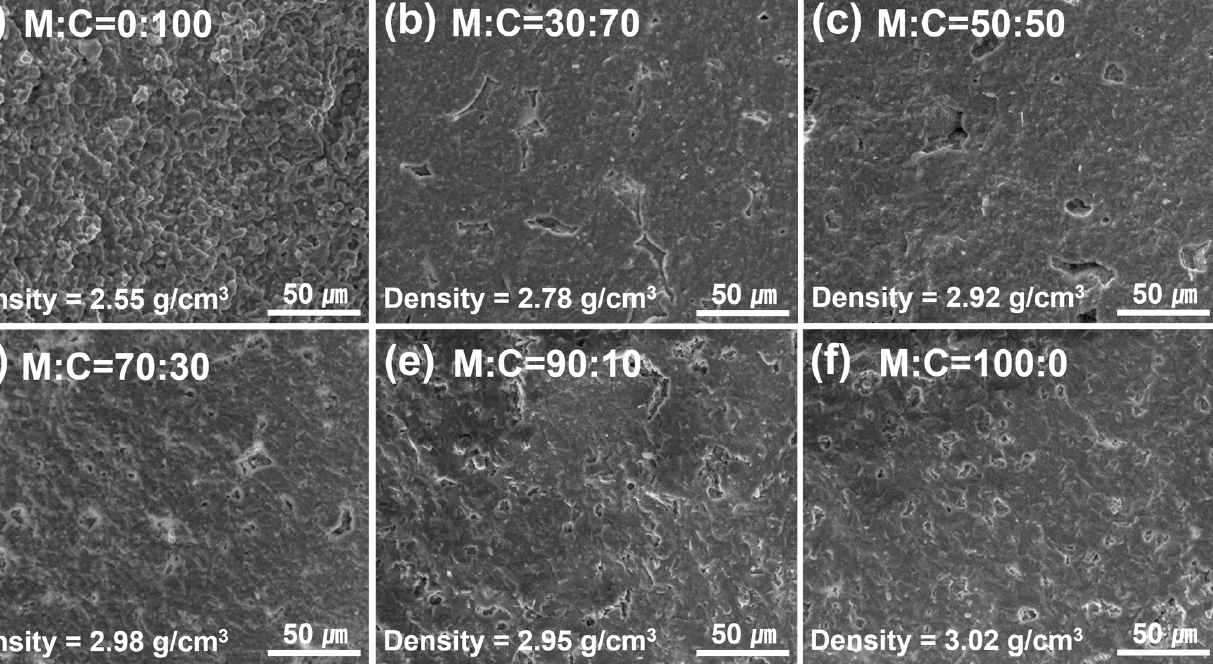
Figure 4. SEM images of the mullite–cordierite composite sintered at 1300 °C: ( a ) M:C = 0:100, ( b ) M:C = 30:70, ( c ) M:C = 50:50, ( d ) M:C = 70:30, ( e ) M:C = 90:10, and ( f ) M:C = 100:0.